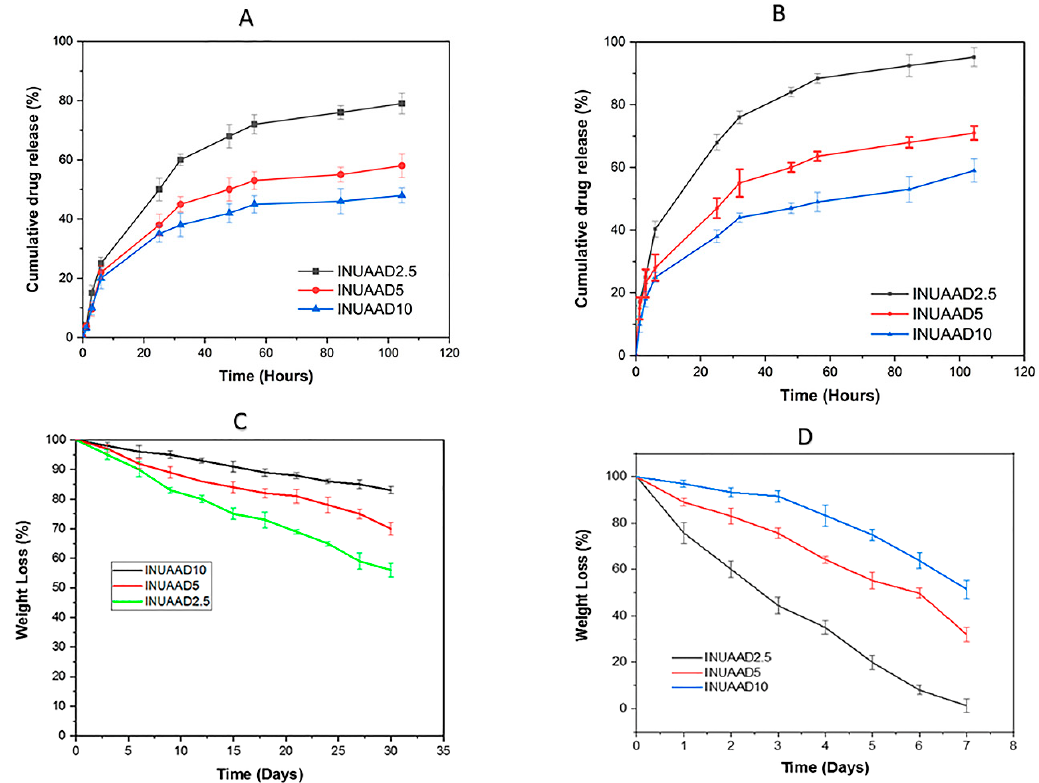
Figure 7. ( A ) The in vitro release rate of 5FU from the hydrogel batches in pH 7.4; ( B ) the in vitro release rate of 5FU from the hydrogel batches in pH 5.0; ( C ) the degradation of the hydrogels in pH 7.4; ( D ) the degradation of the hydrogels in pH 5.0 with the addition of inulinase.